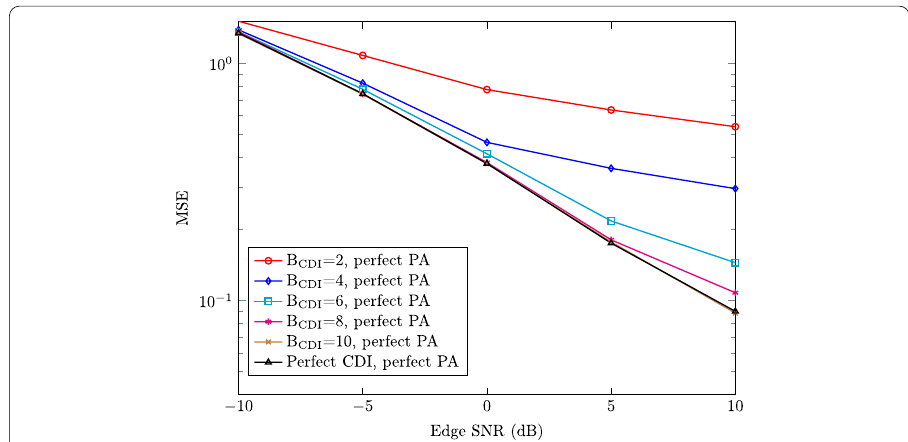
Fig. 14 MSE performance of the CSI codebook based quantization in SFB-CBH proposed scheme with flr = 0.167 , N t = 2 , perfect PA and varying bit number for CDI